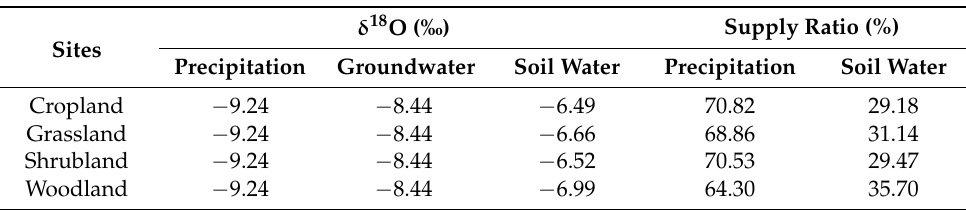
Table 2. Estimation of groundwater recharge ratio by soil water and precipitation under different land uses. δ 18 O (‰) Supply Ratio (%) Sites Precipitation